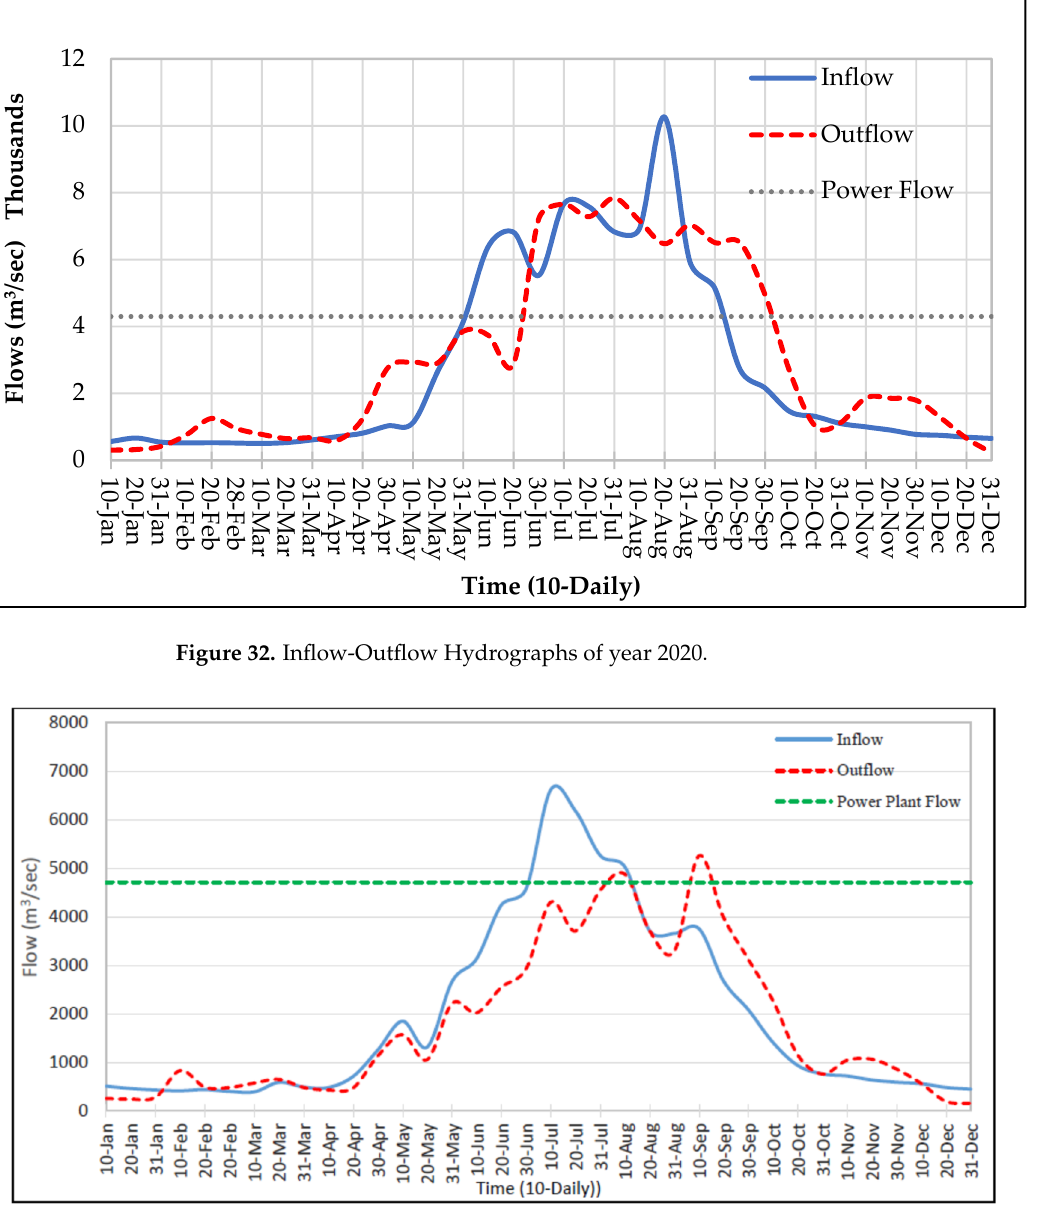
Figure 33. Inflow-Outflow Hydrographs of Application year 2025.